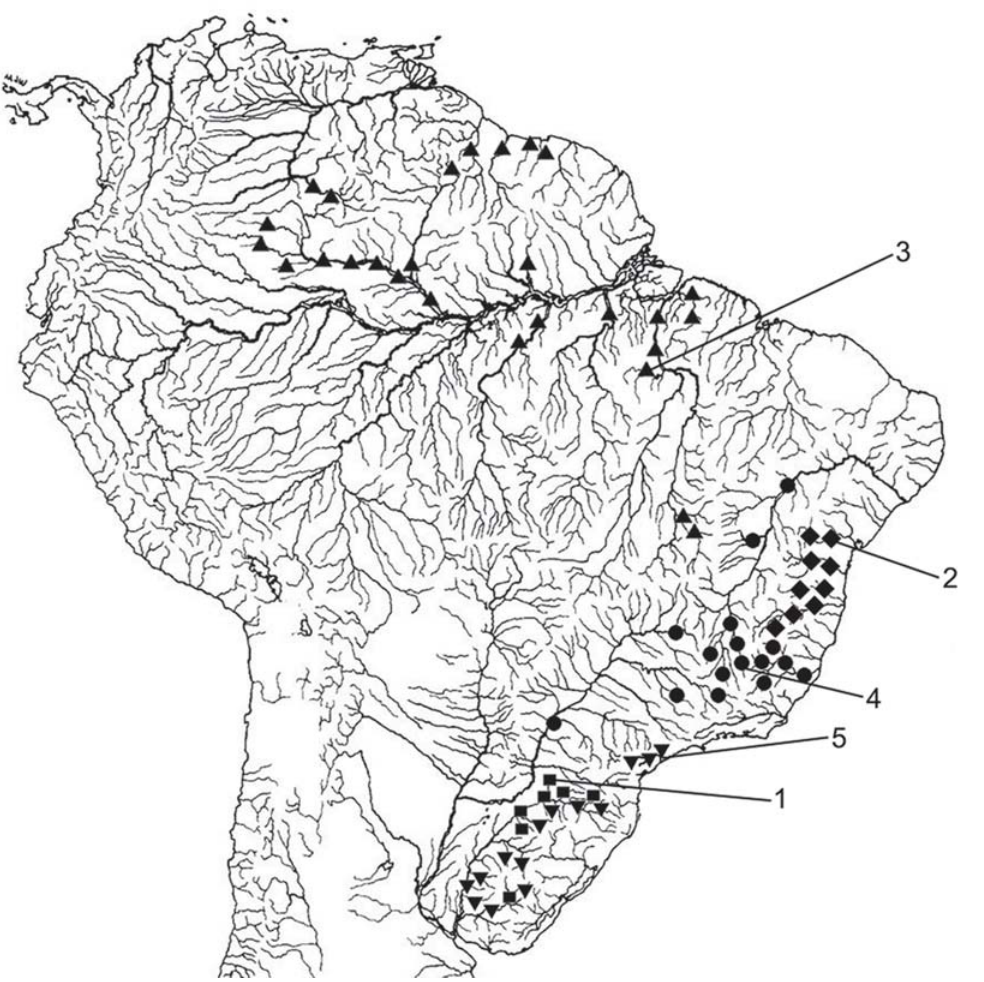
Fig. 3. Map of South America showing geographic distribution of species of the Hoplias lacerdae group based on material examined in this study. Some symbols may represent more than one lot. Numbers indicate type localities of (1) Hoplias australis (squares); (2) H . brasiliensis (losanges); (3) H . curupira (triangles); (4) H . intermedius (dots); and (5) H . lacerdae (inverted